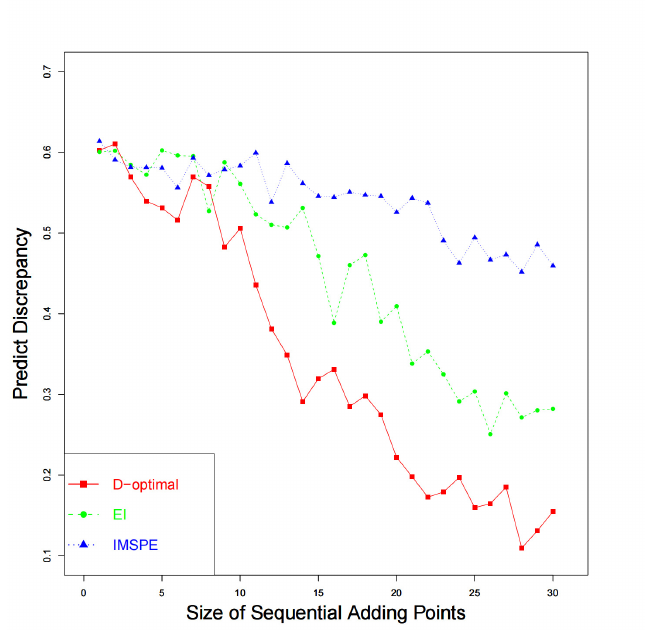
Figure 2. MPD l obtained using the proposed sequential D-optimal method, EI method, and IM- SPE method.